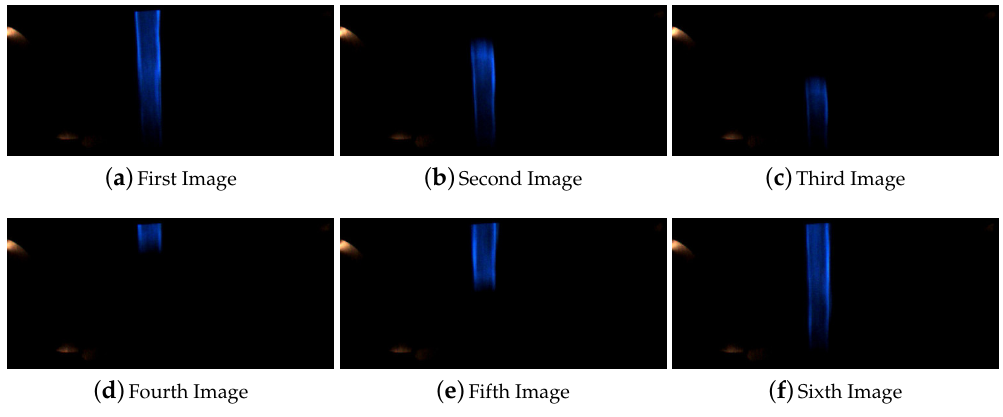
Figure 9. Sequence of images for the line occlusion for 30 cm inside a straight